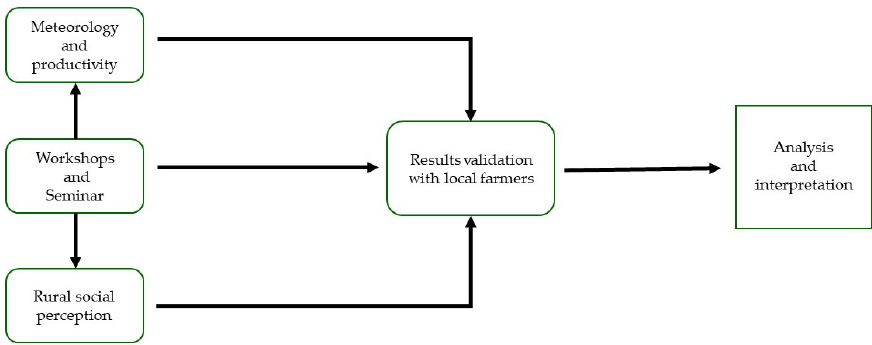
Figure 5. Research model aspects adopted in the study (Source: prepared by the authors).